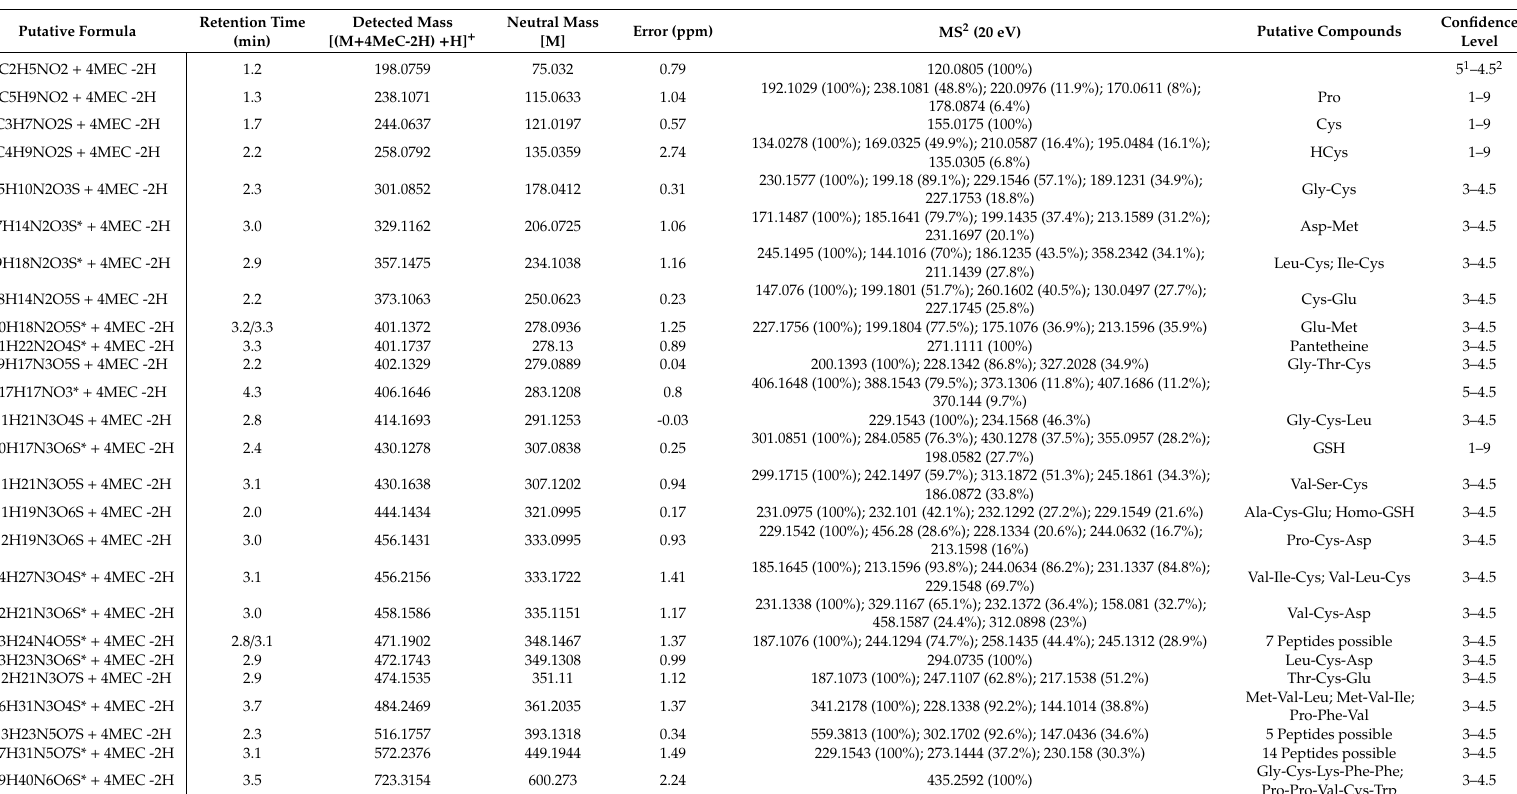
Table 2. Putative annotation of some derivatized compounds. Formula mark with “*” designed compounds which is detected in free form. Error is calculated between detected mass and theoretical adduct mass [(M + 4 MeC − 2H) + H] + . Putative peptides are amino acids combination and not amino acids sequence. Level of confidence are adapted from Sumner et al. 2014 and Schymanski et al. (2014)